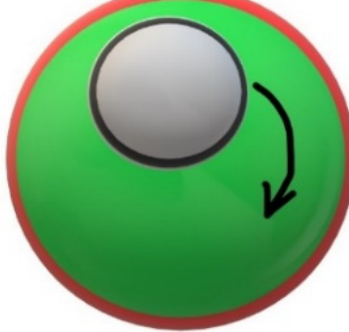
Figure 5. Schematic of the rotating Janus droplet with a black-marked MNP layer at the oil/oil interface and a red-marked AuNP layer at the oil/water interface.